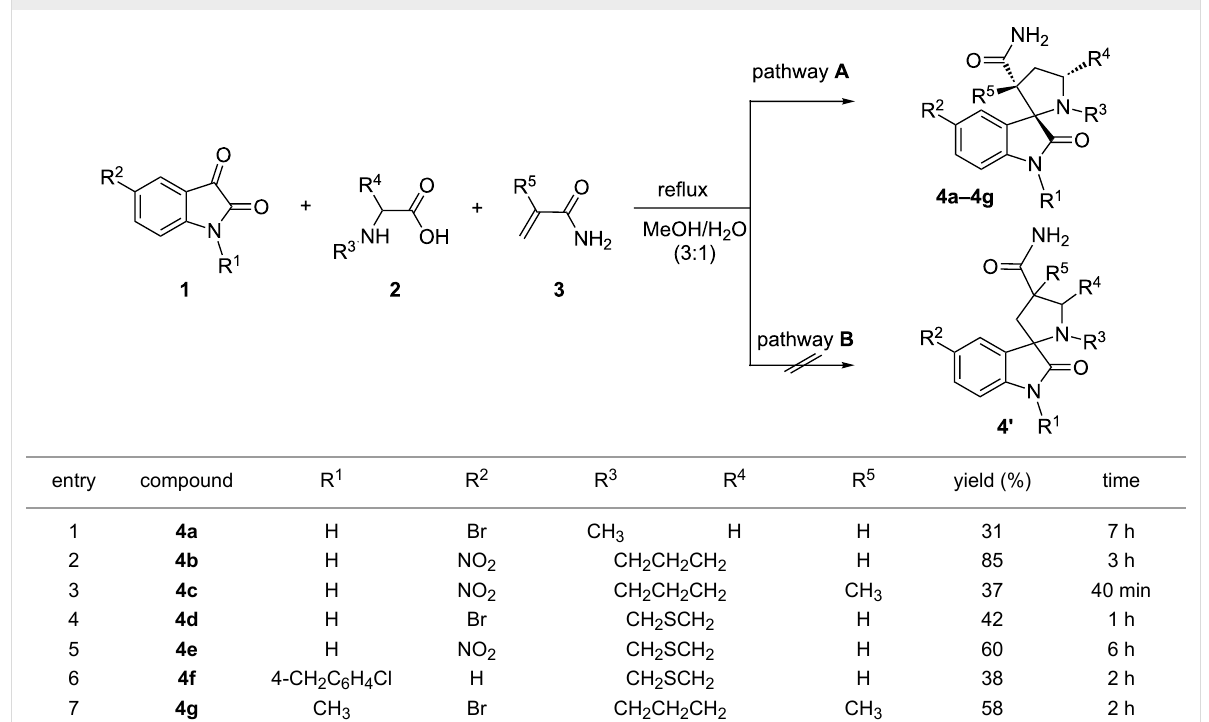
Table 1: Three-component synthesis of spirooxindoles 4a–4g